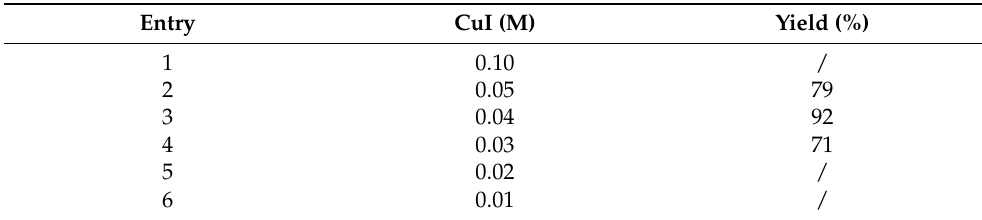
Table 4. Effect of catalyst loading on the polymerization carried out under N 2 atmosphere for 24 h in the presence of CuI and Et 3 N in THF. T = 90 ◦ C; [P[5](OTf) 2 ] = [9,10-diethynylanthracene] = 0.30